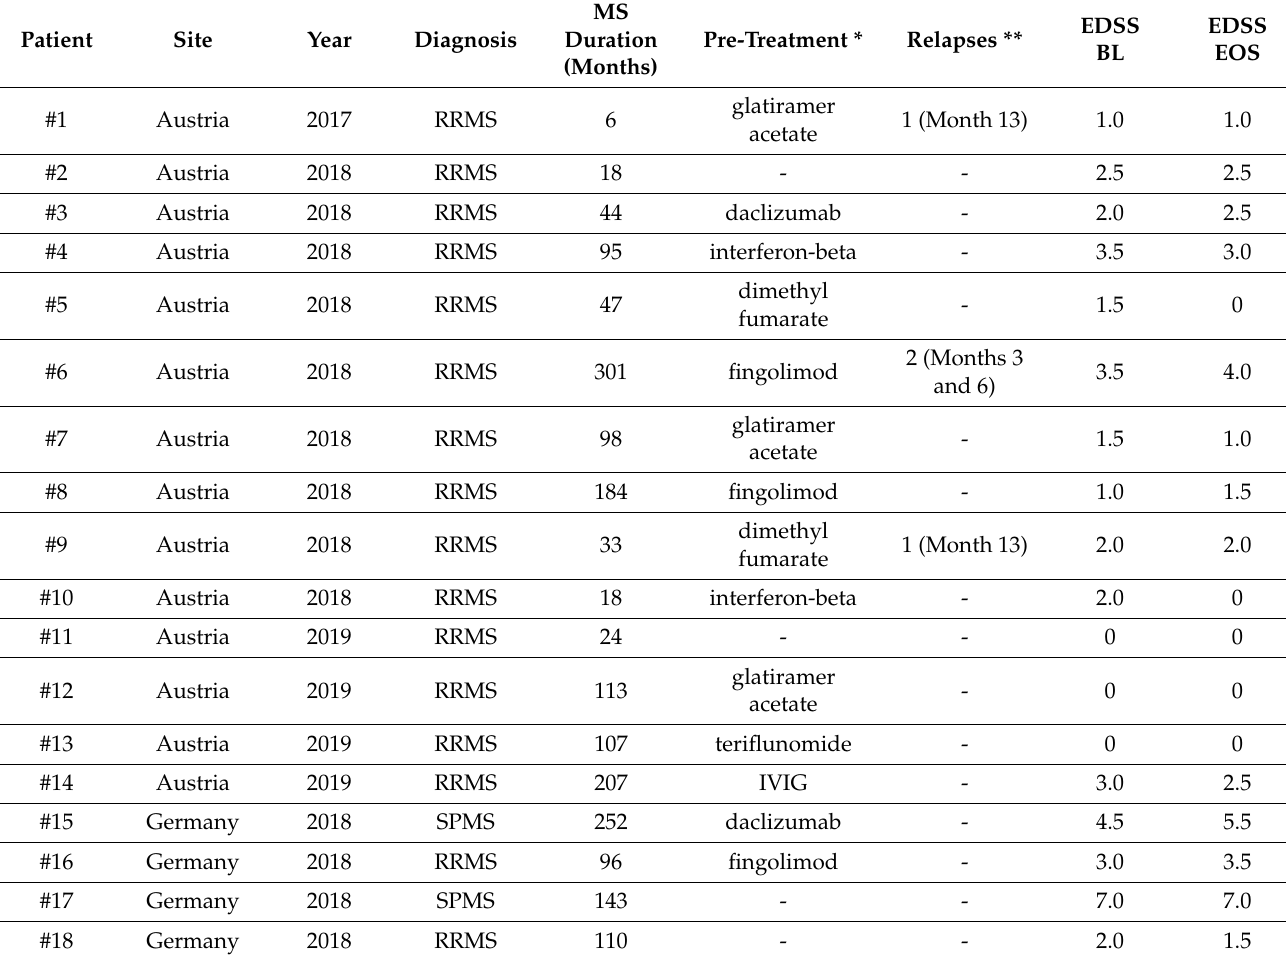
Table A1. Site/year of patient recruitment, clinical characteristics and